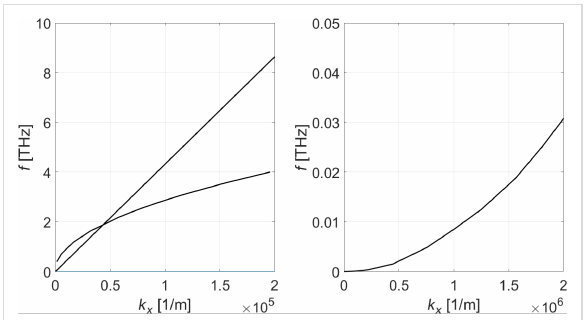
Figure 4: Dispersion relations for the coupled u x – u z – phonon modes of single-layer MoS 2 . The right plot is a zoomed version of the left plot. Note again the parabolic dispersion of one predominantly acoustic mode away from the Γ point besides a linear dispersion predominant acoustic mode. We also obtain a second nonlinear mode starting at ( k , ω ) = (0,0), which stems from the rather complicated frequency-de- pendent permittivity of MoS 2